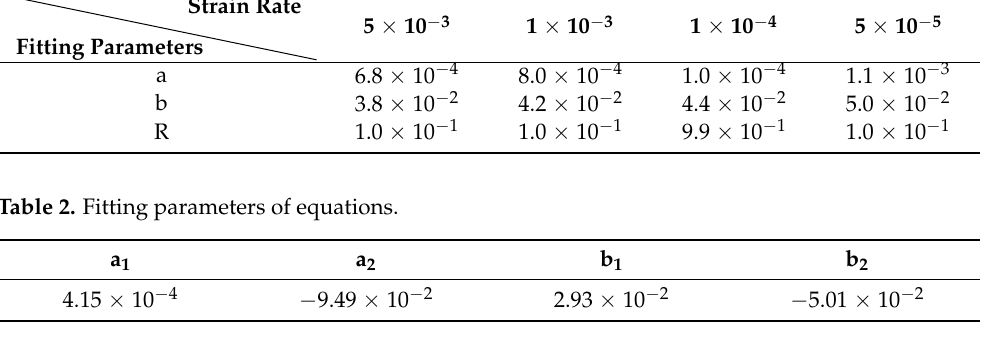
Figure 4. Curve fitting on test results at different strain rates.